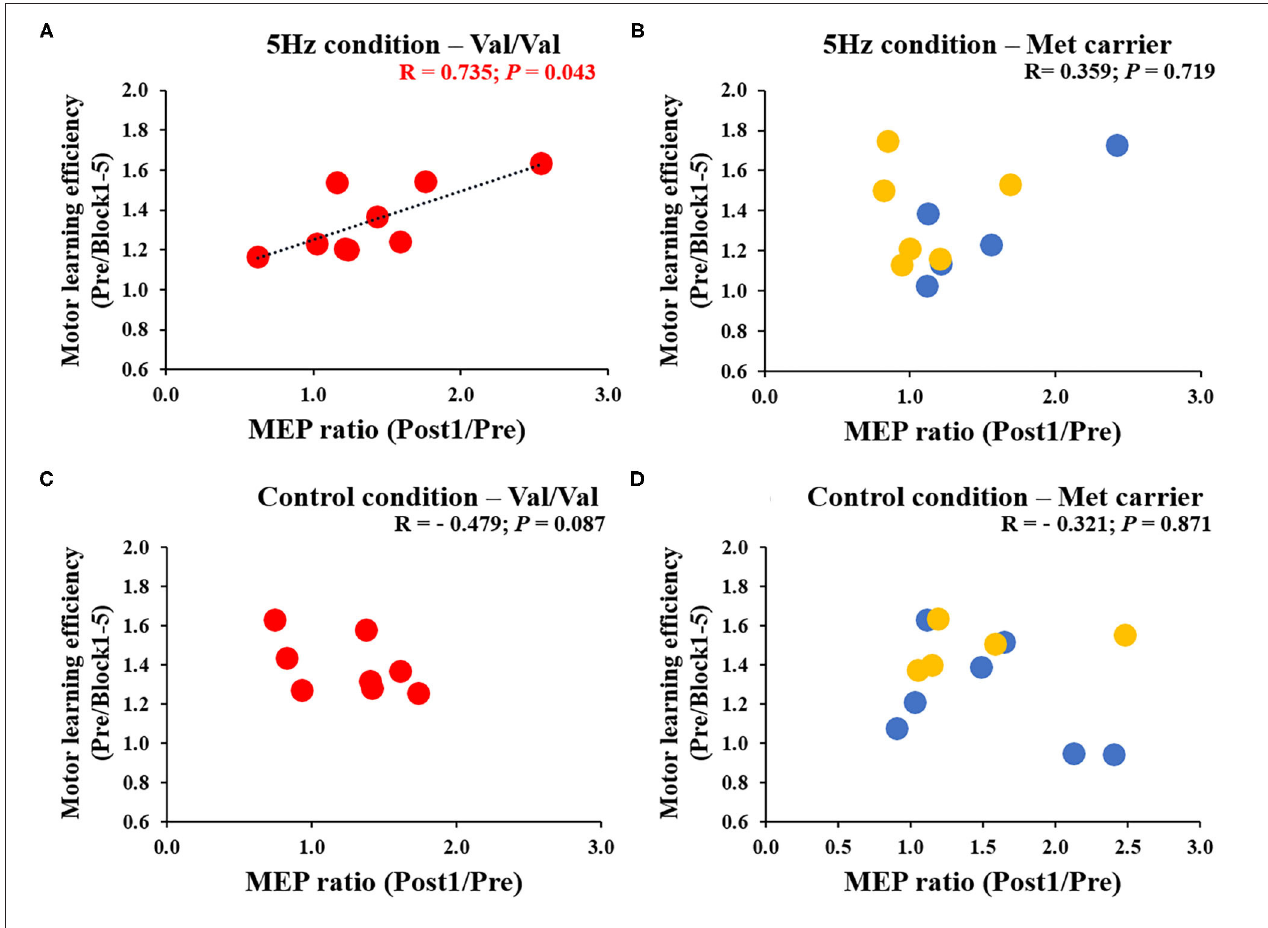
FIGURE 7 | (A–D) Correlation between MEP ratio (Post1/Pre) and motor learning efficiency to Pre for each genetic polymorphism of BDNF . The red circles indicate the Val/Val, the blue circles are the Val/Met, and the yellow circles are the Met/Met genotypes. In the RPM condition alone, there was a significant correlation between MEP ratio and motor learning efficiency for the Val/Val genotype ( r = 0.735; P = 0.043). These results showed that in the case of the Val/Val genotype in the RPM condition, corticospinal excitability was increased in individuals whose task errors were reduced by motor learning